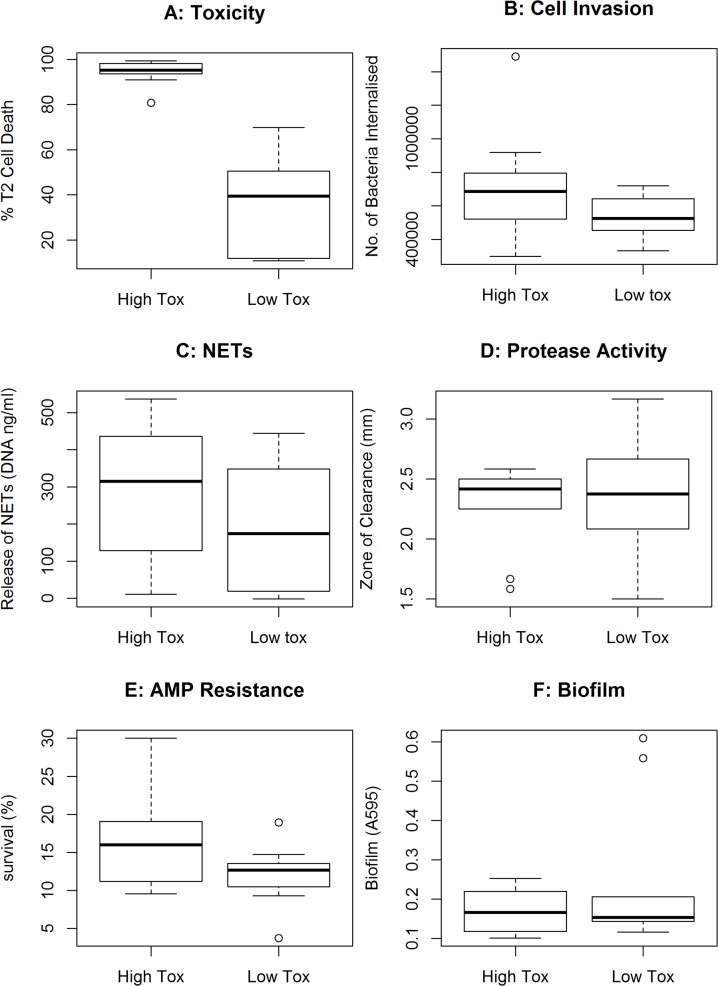
Explaining the association between toxicity and infection severity.A range of virulence assays were performed on a subset of 10 high- and 10 low-toxicity isolates from the USA300 collection to identify the biological feature that explains the observed inverse correlation between toxicity and disease severity. (A) The toxicity of the subset of isolates is provided for comparison. (B) The ability of the bacteria to invade EA.hy926 endothelial cells. (C) The ability of the bacteria to induce the release of neutrophil extracellular traps (NETs). (D) The release of proteases by the bacteria. (E) Resistance of the bacteria to human neutrophil defensin-1. (F) The ability of the bacteria to form biofilms. The p-value for the comparison between the high and low toxicity isolates was greater than 0.05 for all traits with the exception of toxicity. The medians are presented as horizontal bars, with the boxes and whiskers showing the 1st and 3rd quartile and interquartile ranges. To access this data see S3 Data.